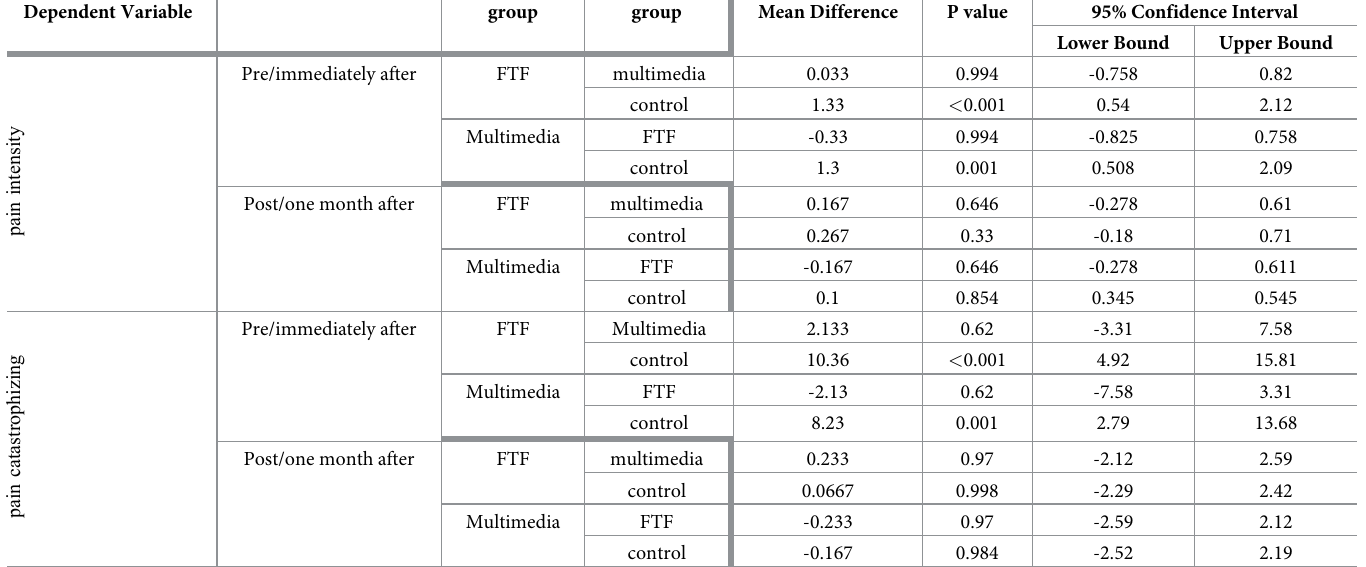
Table 3. The results of Tukey’s test.